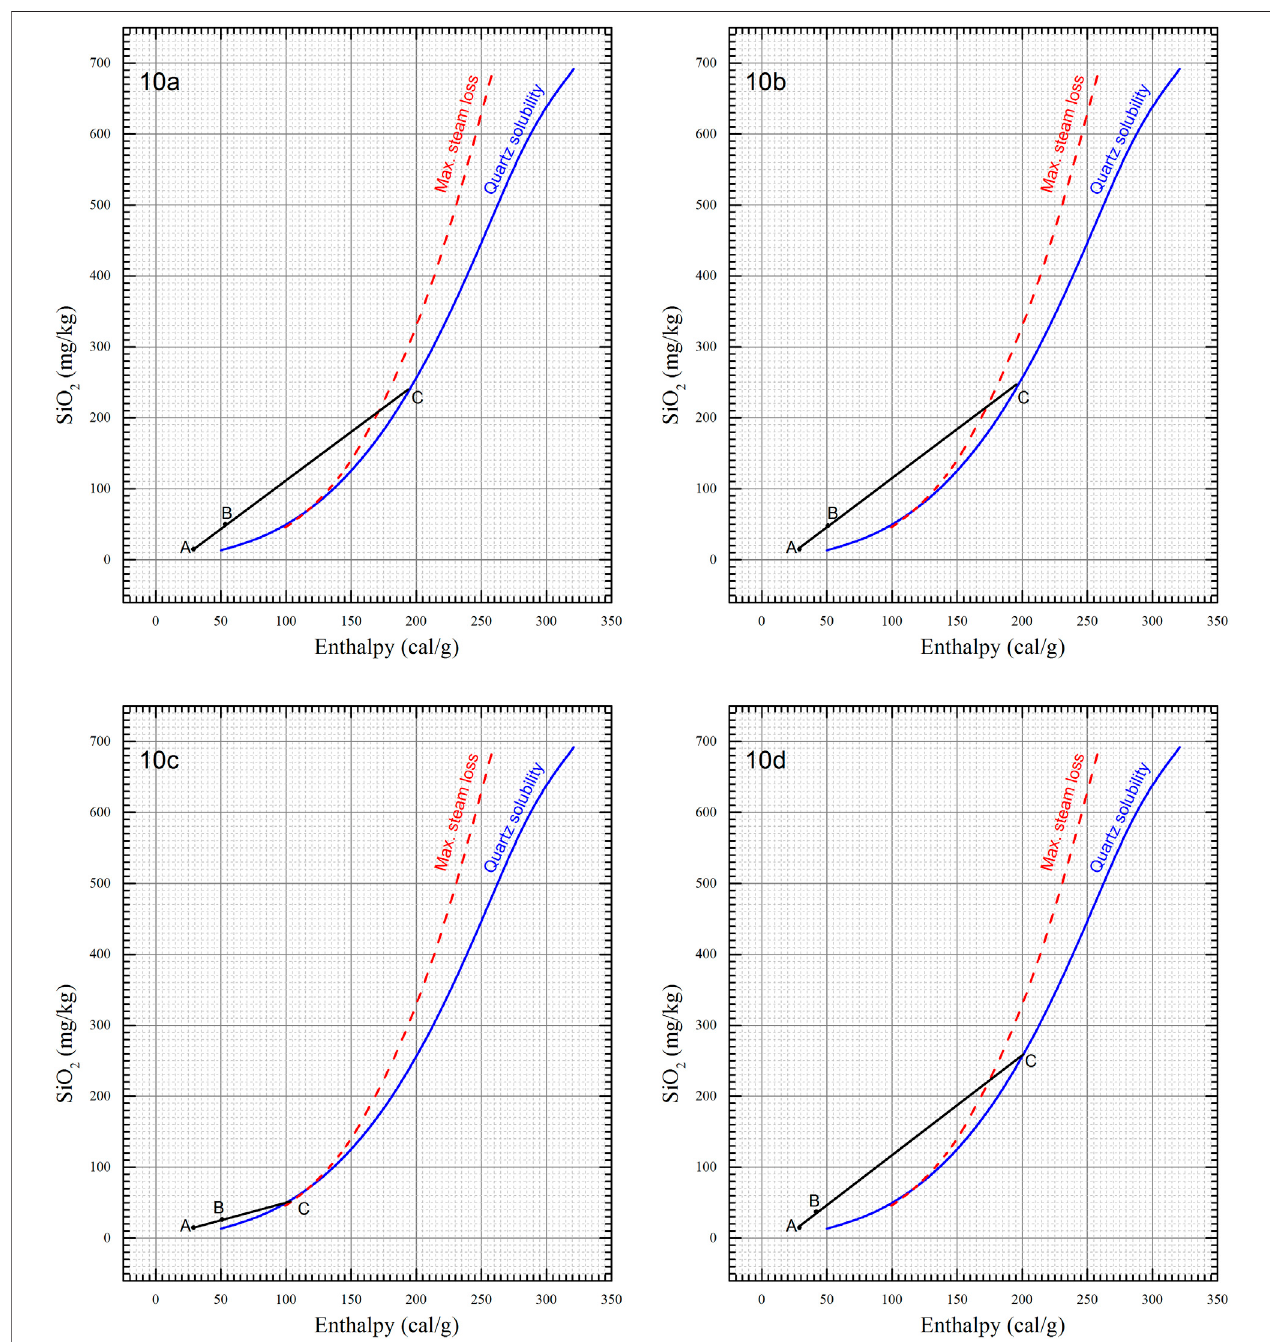
FIGURE 7 | The silica-enthalpy diagram of hot spring sample